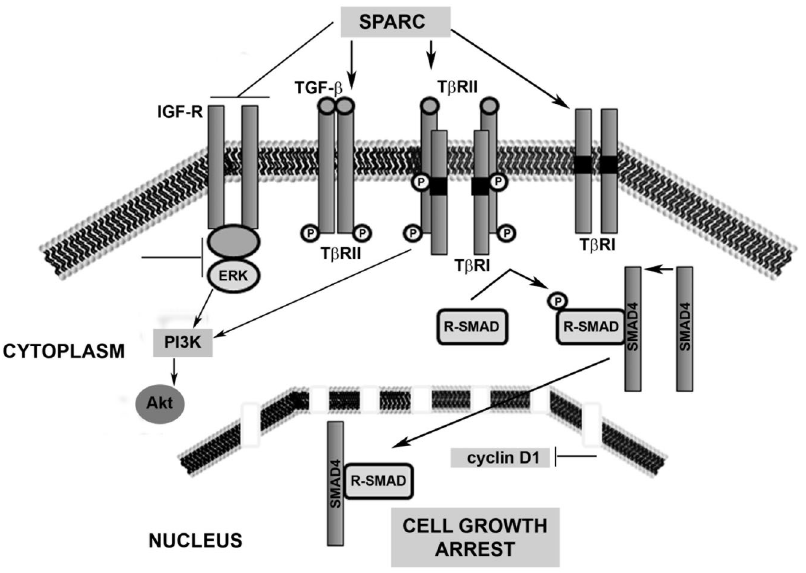
Figure 7. A working model of LEC secretome mechanisms for the modulation of epithelial cell proliferation. SPARC may inhibit corneal epithelial cell proliferation by targeting IGF, TGF- b and Smad2/3 signalling that is established in corneal wound healing. In the corneal epithelium, sPARC may inhibit the IGF receptor and activate the TGF- b . Inhibition of epithelium turnover may occur through sPARC-mediated attenuation of extracellular regulated kinase (ERK), phosphoinositide-3-kinase (PI3K) and Akt in the cytoplasm leading to reduction in the activity of the cell cycle regulator, cyclin D1 in the nucleus.